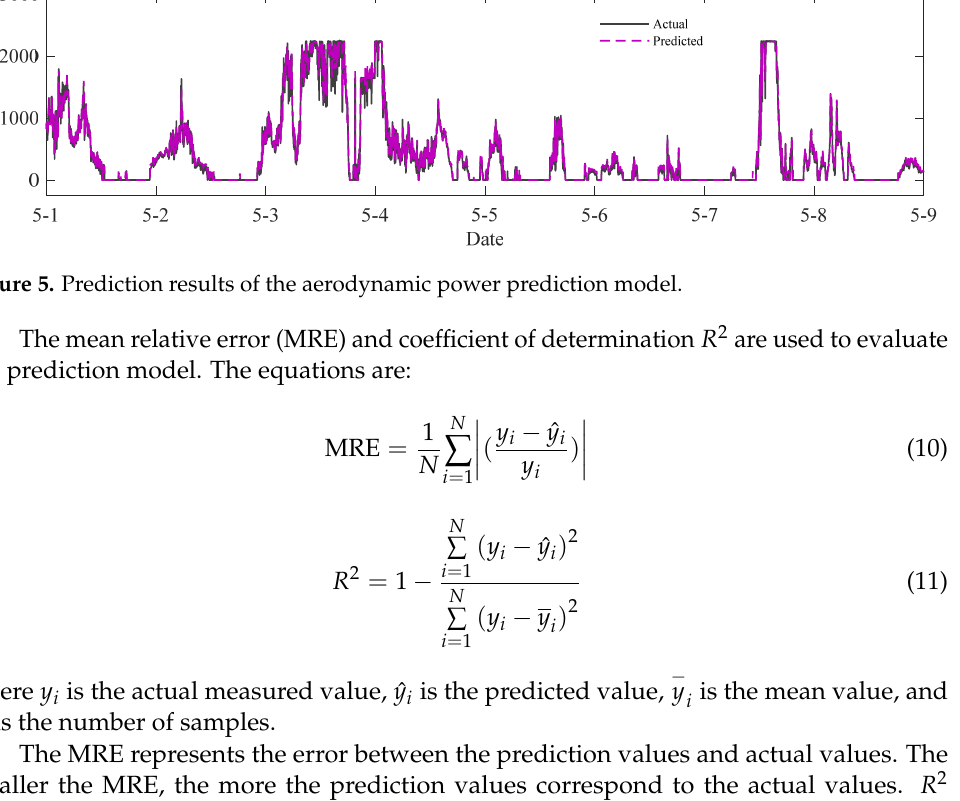
Table 2. Comparison of methods.